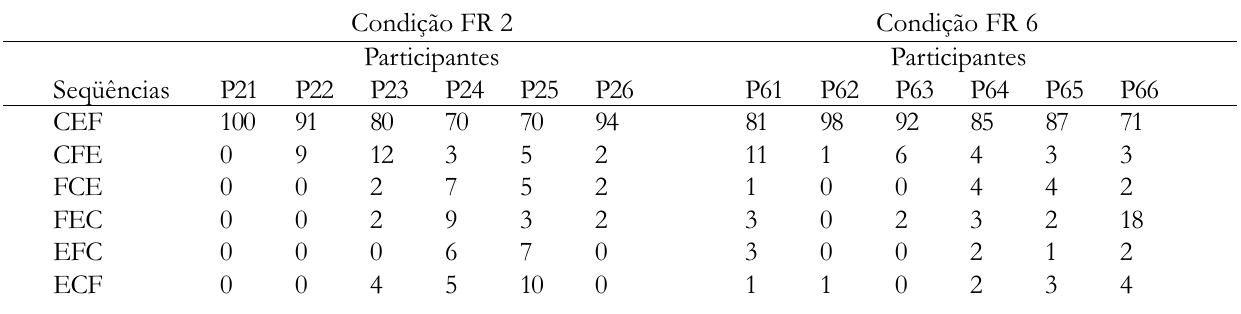
Porcentagens de Seq(cid:252)Œncias de Respostas Emitidas Durante a Modelagem na Fase 1, pelos Participantes que Atingiram o CritØrio de Encerramento desta